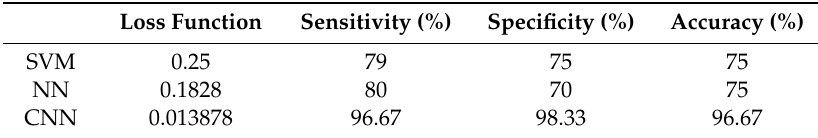
Table 3. Comparative results of different models.